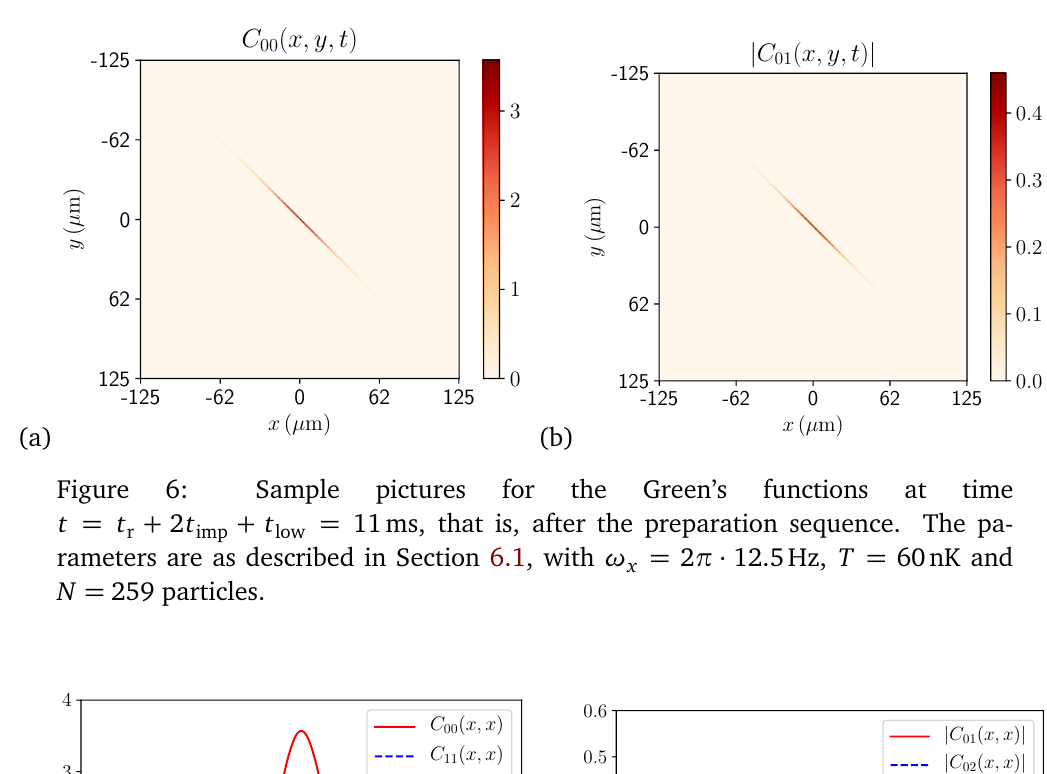
= 2 π · 12.5Hz, T = 60nK and x